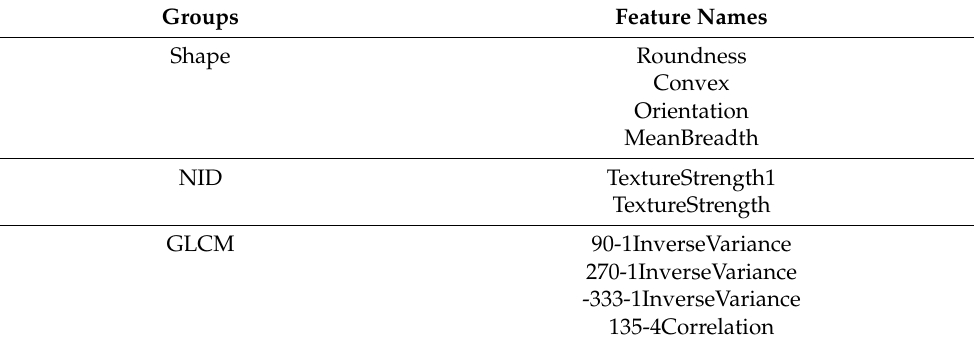
Figure 4. A subset of 24 features containing 95% of the principal components was obtained by principal component analysis (PCA). Table 5. Features reduction by PCA (Top 10).